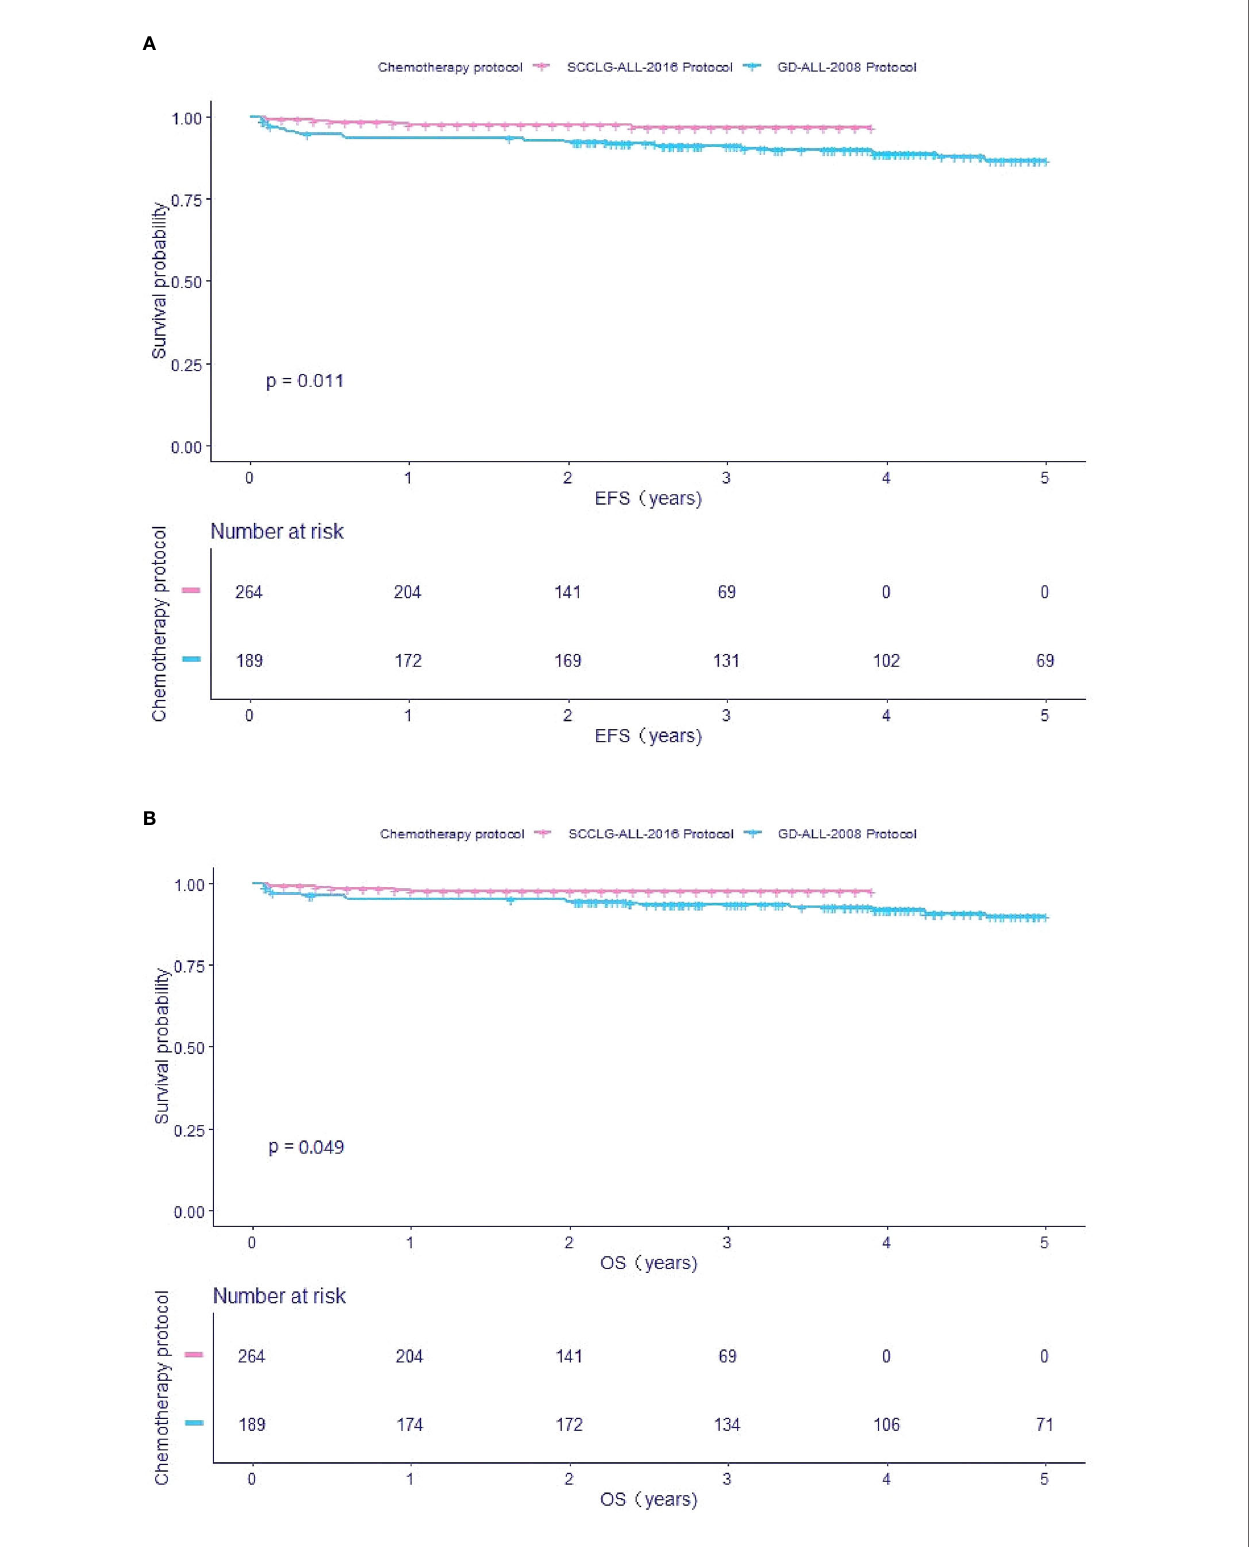
FIGURE 2 | Survival cures of ETV6/RUNX1-positive pediatric B-ALL with different chemotherapy protocol. (A) The cumulative event-free survival of GD-ALL-2008 and SCCLG-ALL-2016 patients. (B) The cumulative overall survival of GD-ALL-2008 and SCCLG-ALL-2016 patients.